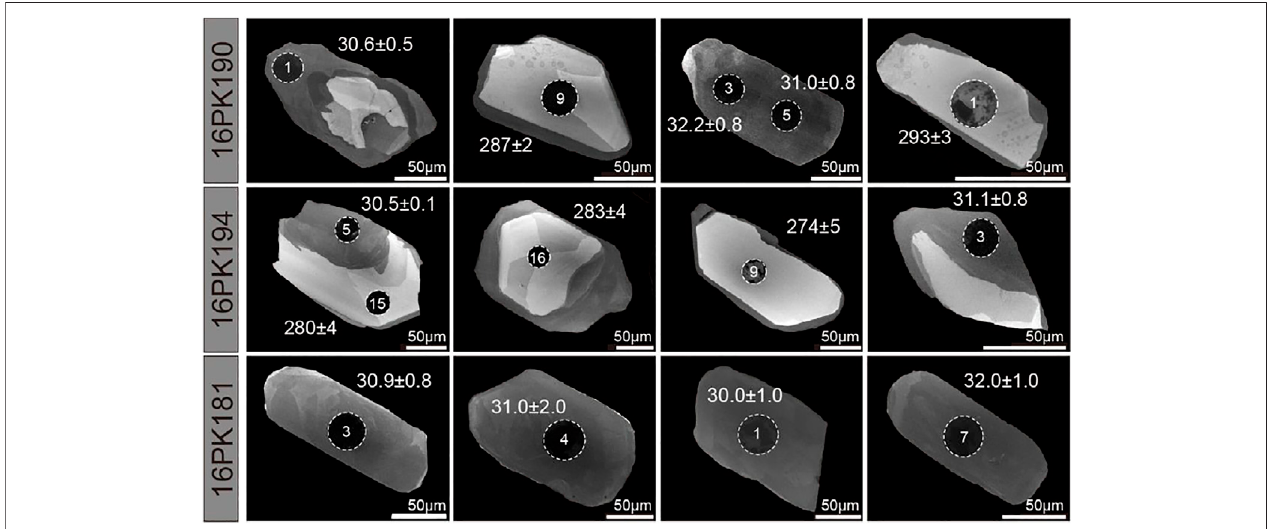
FIGURE 5 | Cathodoluminescence images of zircons from Stak samples. White digits are U-Pb ages, dashed cycles are analysis spots with analytical numbers. The age unit is Ma.